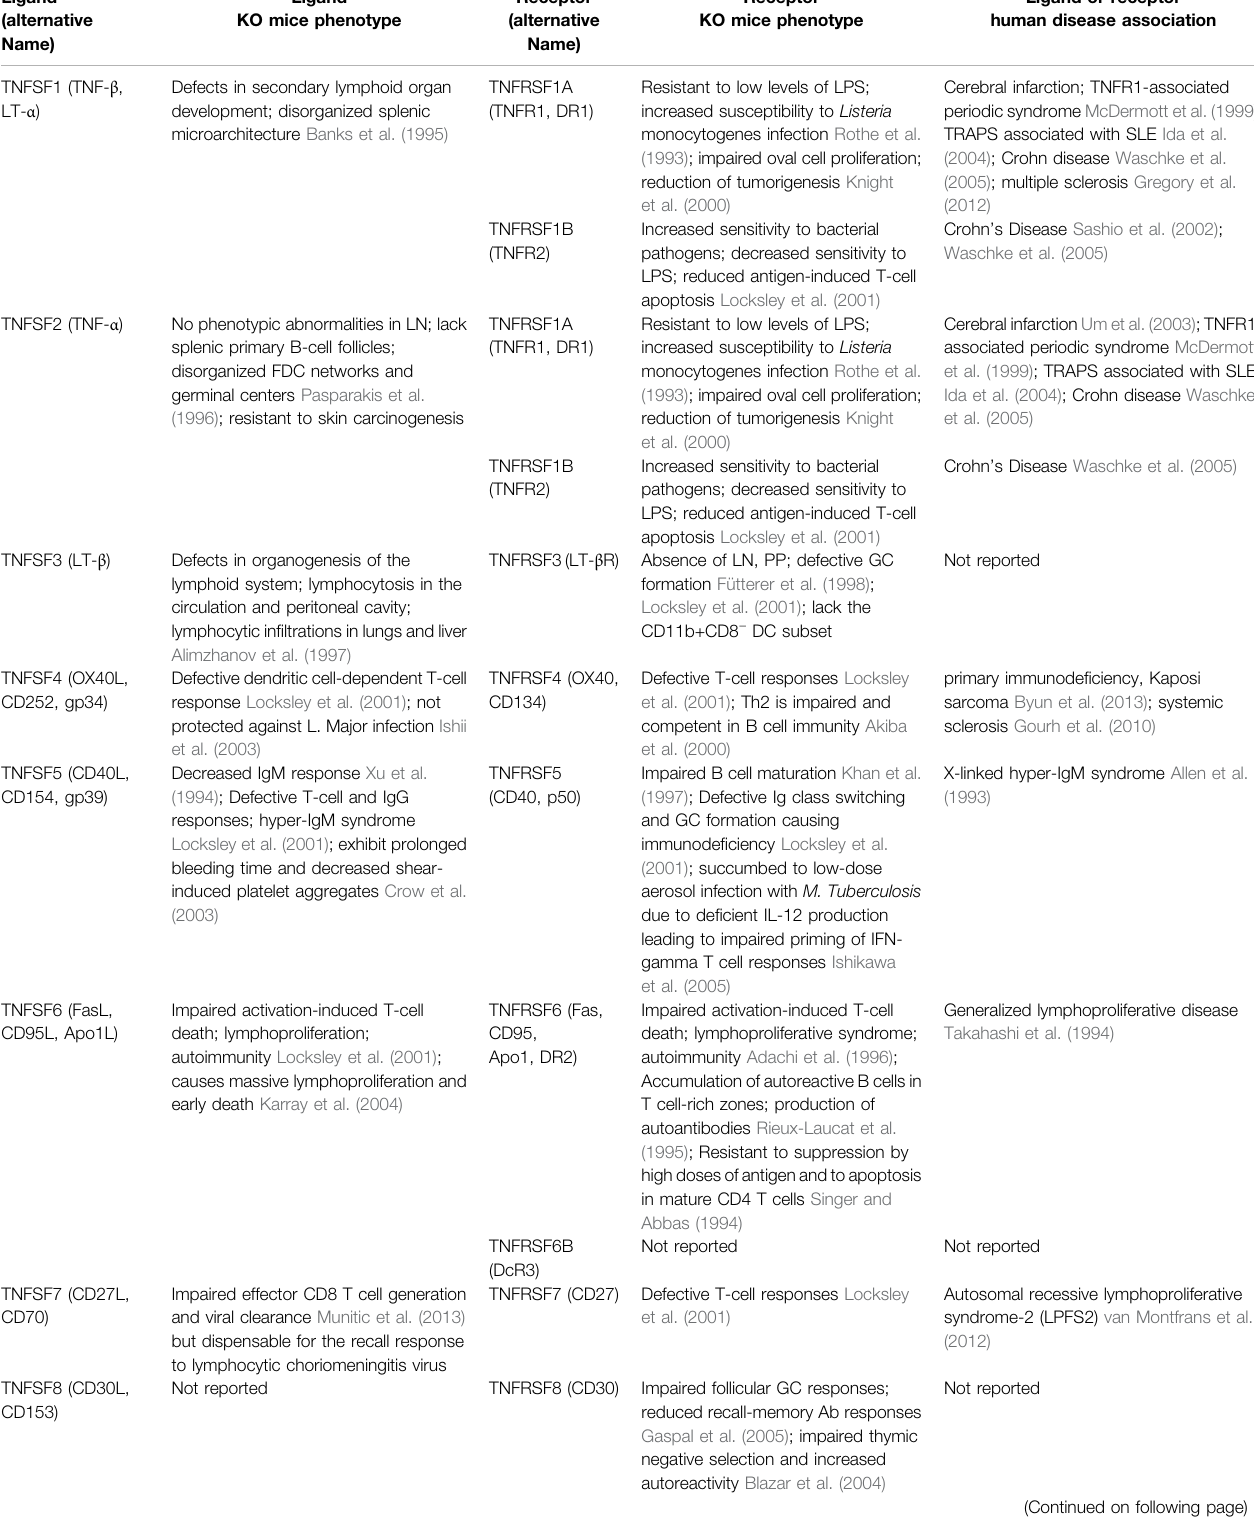
TABLE 1 | Tumor necrosis factor superfamily ligands and receptors and their